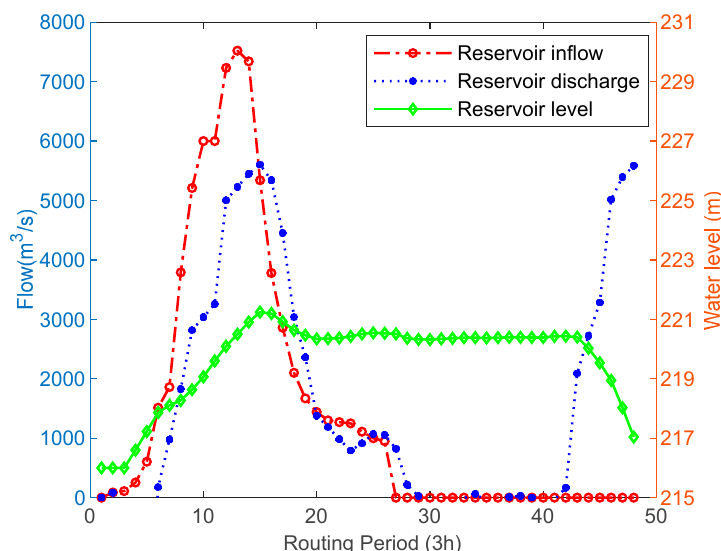
Figure 8. Operation process using CF-BES for reservoirs in Luanhe River Basin.